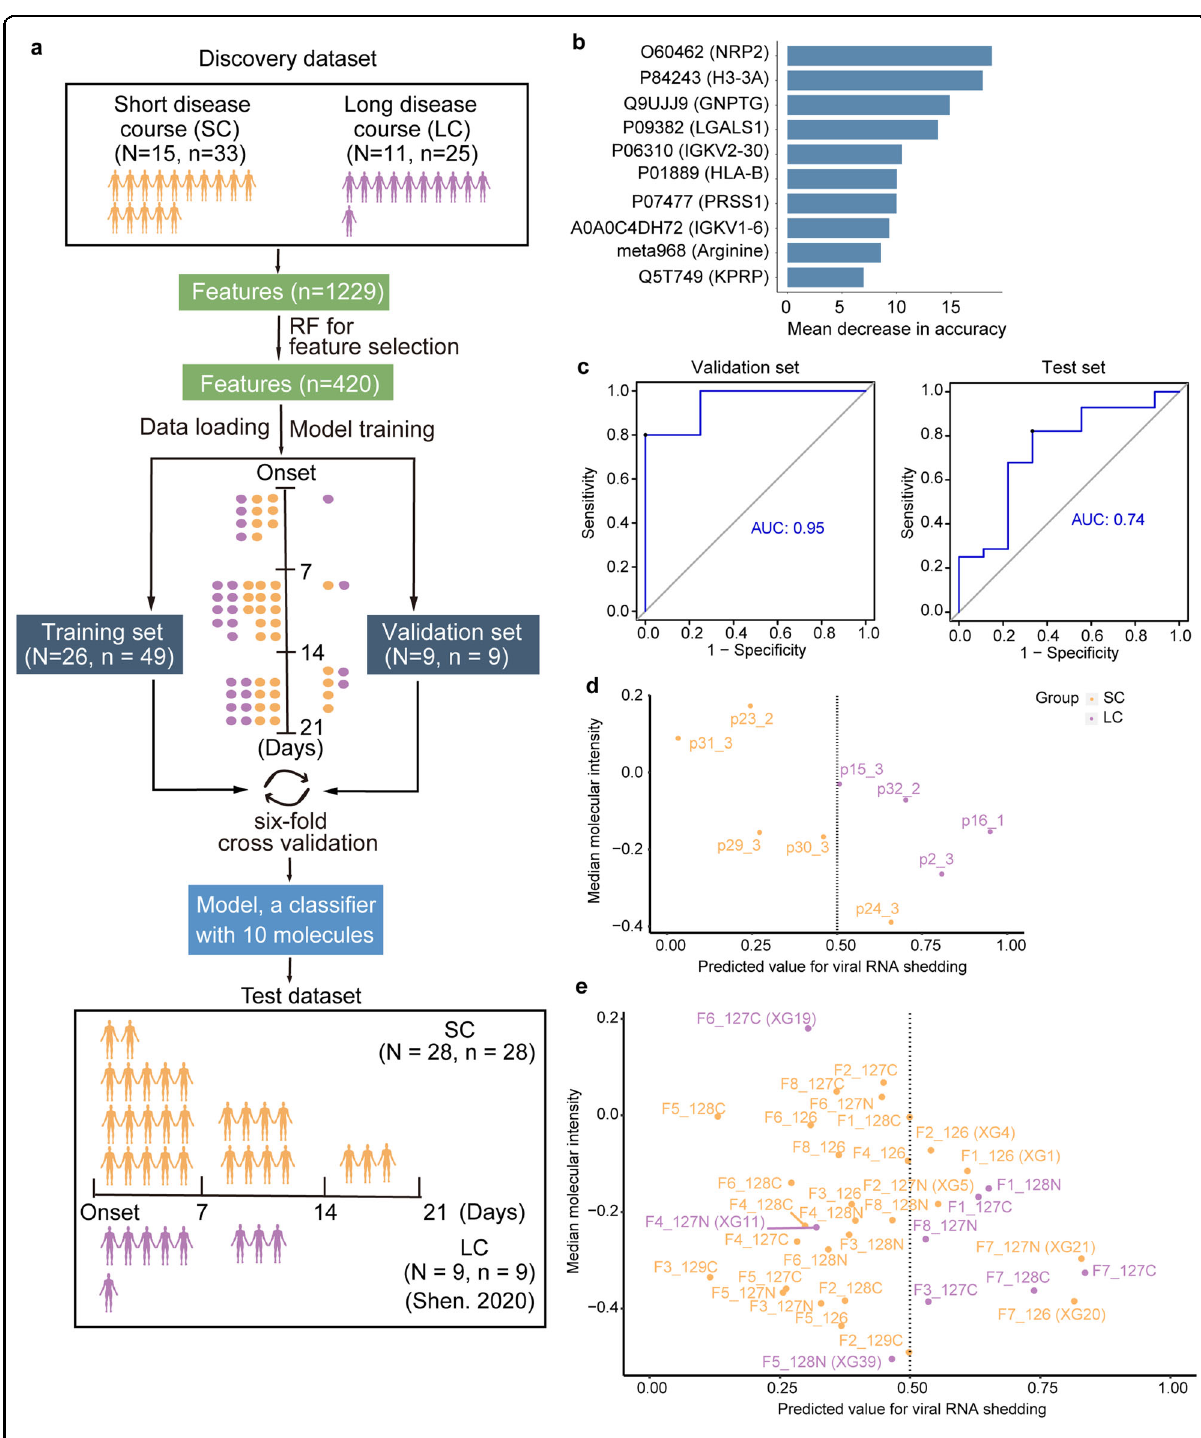
Fig. 6 Machine learning model for disease course prediction. a Work fl ow for machine learning; RF random forest. b The top ten features selected by the machine learning model. c The ROC of validation dataset (left panel) and independent test dataset (right panel). d , e Performance of the model in the validation ( d ) and the independent test datasets ( e ). Orange represents the SC group and purple represents the LC